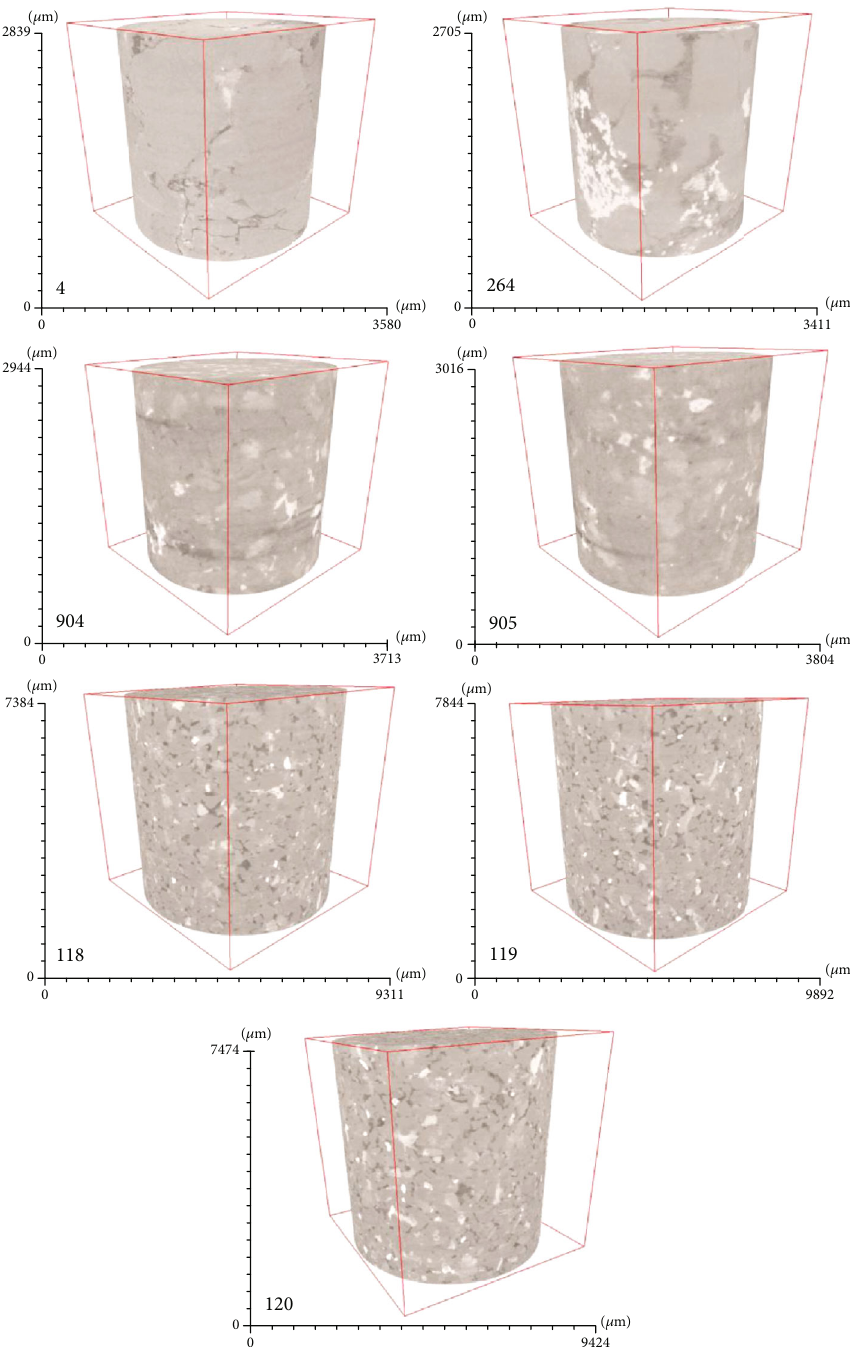
Figure 7: The 3D reconstructions of the seven